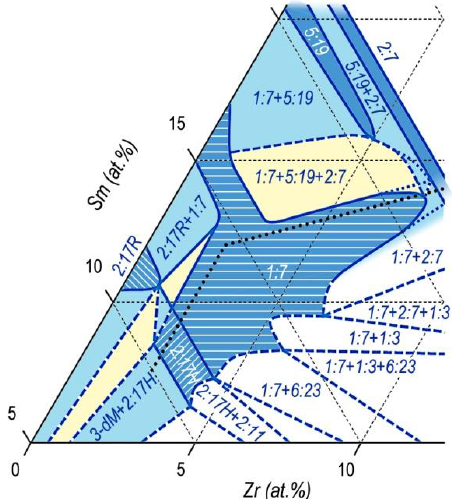
Figure 13. Sketch of the 3-dM angle of the quasi-ternary (Co,Cu,Fe)–Sm–Zr phase diagram for a temperature range of 1160–1190 °С.